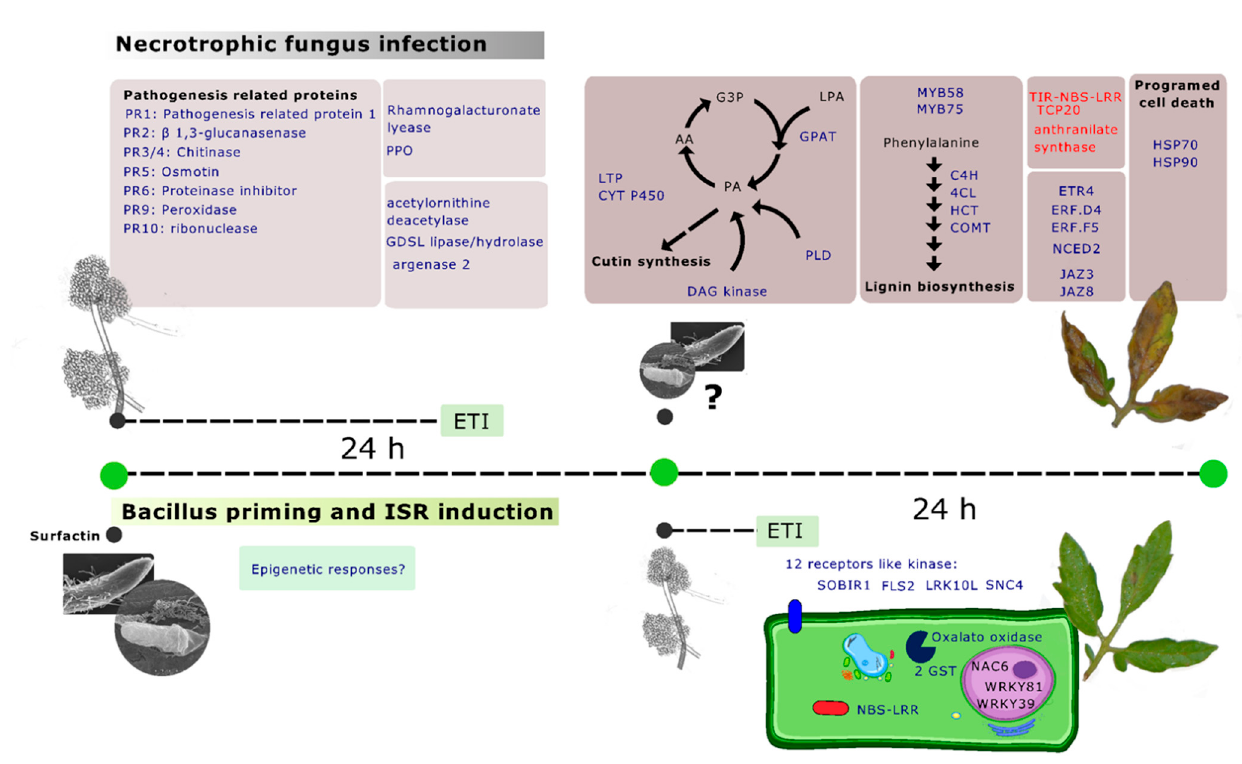
Figure 5. Schematic representation of the “plant–bacteria–fungi” pathosystem evaluated in this study. ( Top ): gene expression profile in P + F and P + F + B at 24 h after B. cinerea infection. A set of pathogenesis-related proteins is activated ( left ); however, the incorporation of BBC047 into the system ( right ) generates the worst damage in tissues expressed as genes related to SAR signals, as well as lignin biosynthesis and programed cell death. ( Bottom ): comparison of molecular response in the P + B and P + B + F treatments. Although few genes were differentially expressed between CP and P + B treatments, the incorporation of B. cinerea induced receptor-like kinases, NBS-LRR, transcription factors and related genes to antioxidant systems. Blue represents expressed genes, and red represents repressed genes.